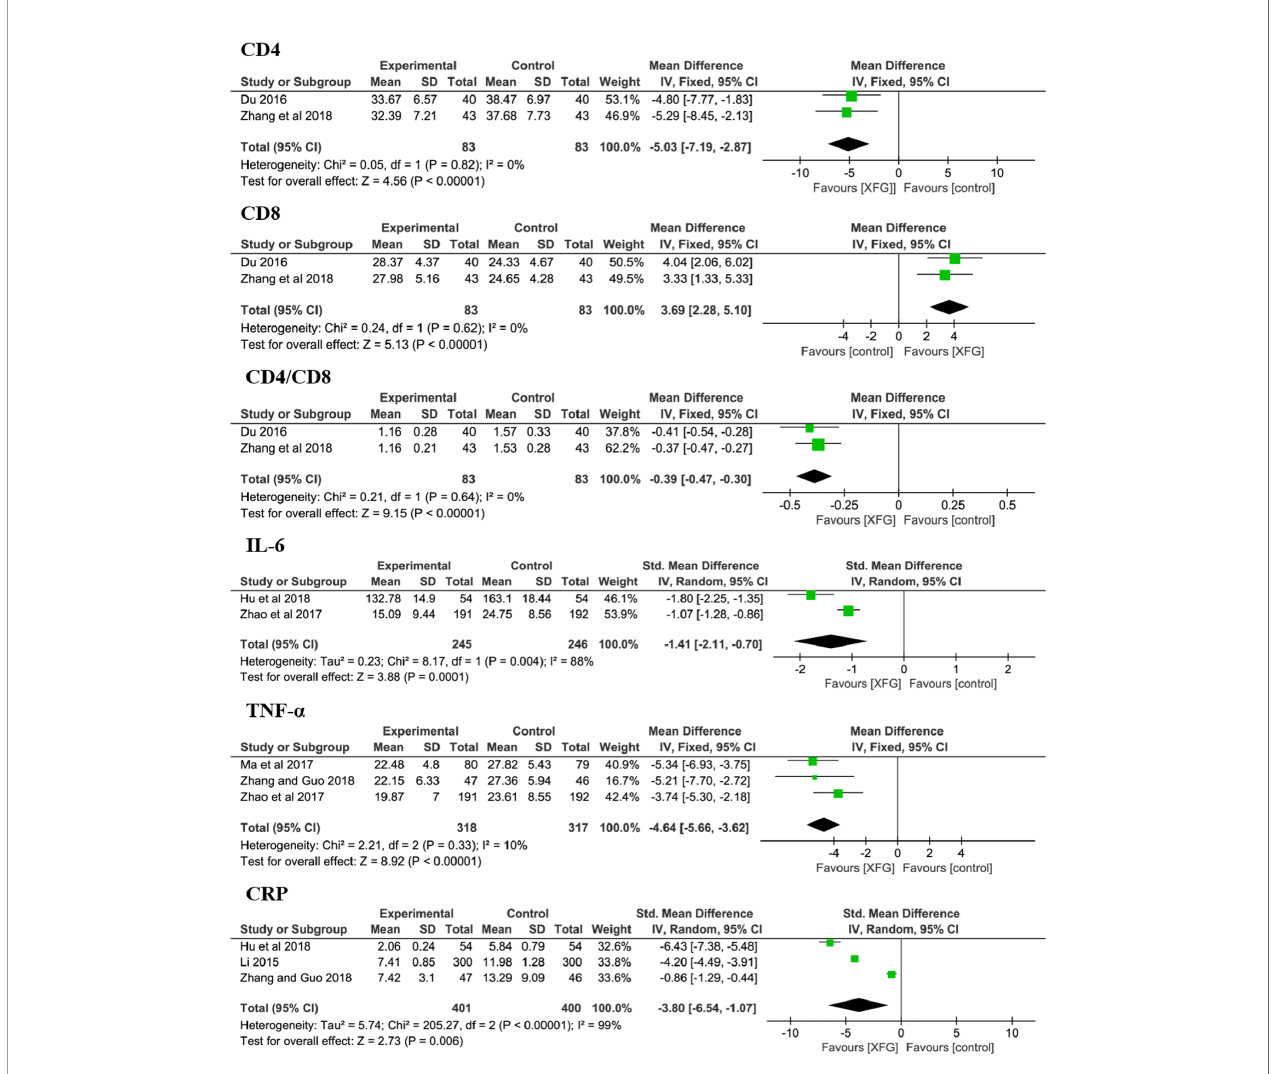
FIGURE 8 | Forest plot and meta-analysis of CD4, CD8, CD4/CD8, IL-6, TNF- a , and CRP levels.